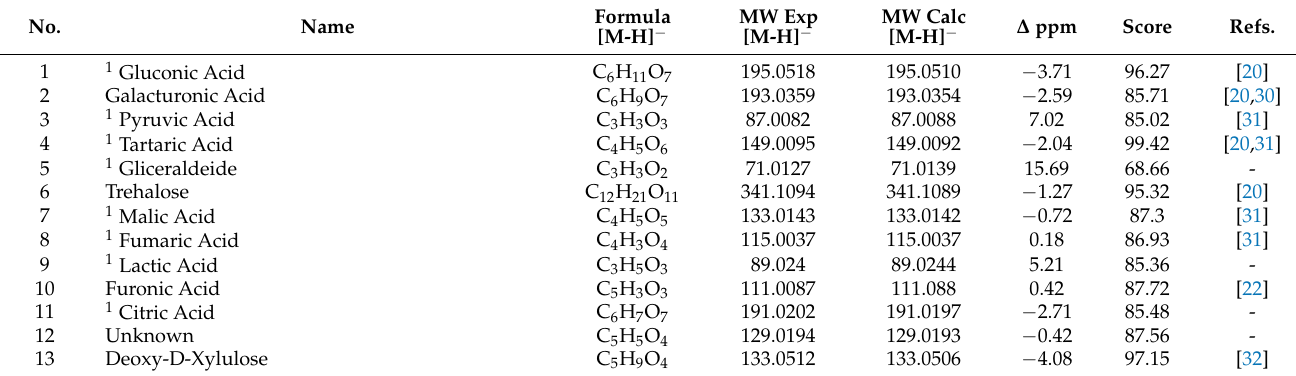
Table 4. Compound [M-H] − identification attempts by HPLC/DAD/TOF analysis in the grape marcs analyzed.